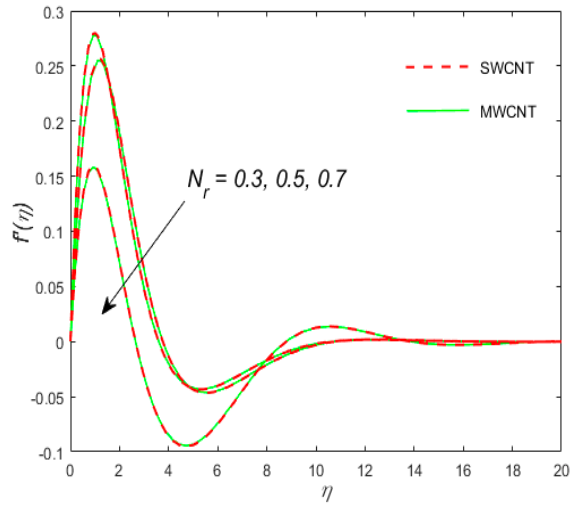
Figure 5. The variation of the velocity distribution profile f’ ( η ) for the case of SWCNT and MWCNT versus the similarity variable for the distinct values of the buoyancy ratio parameter ( N r ).